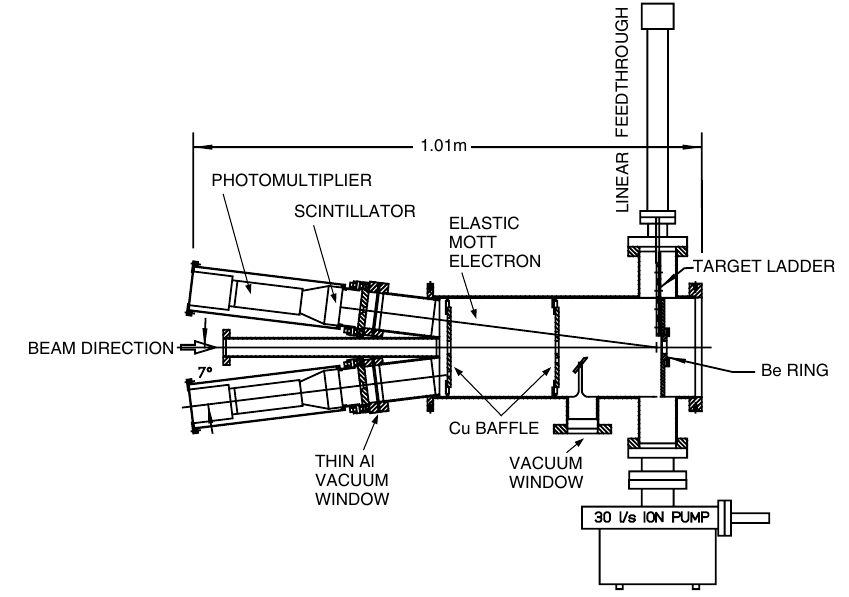
FIG. 2. Schematic of the injector Mott polarimeter as installed in the 5 MeV region of the CEBAF